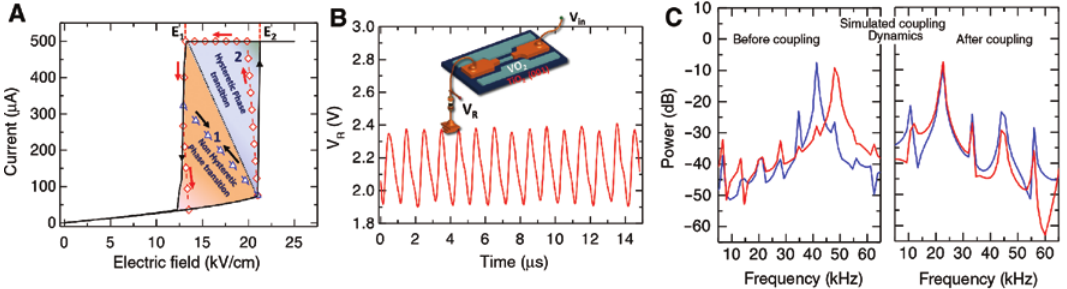
device illustrating the hysteretic window. (B) Measured characteristics show oscillations 2